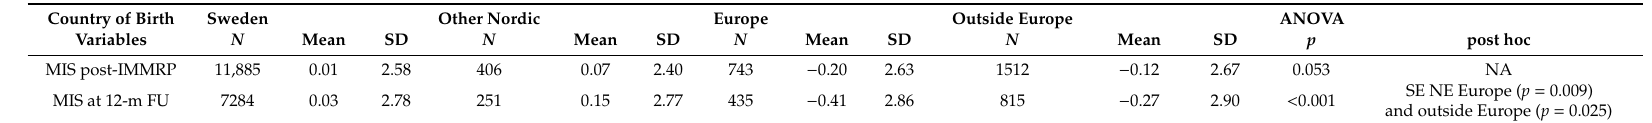
Table 6. MIS across country of birth post-IMMRP (n = 14,546) and 12-month follow-up (n = 8785). ANOVA and post-hoc tests are to the far right. Country of Birth